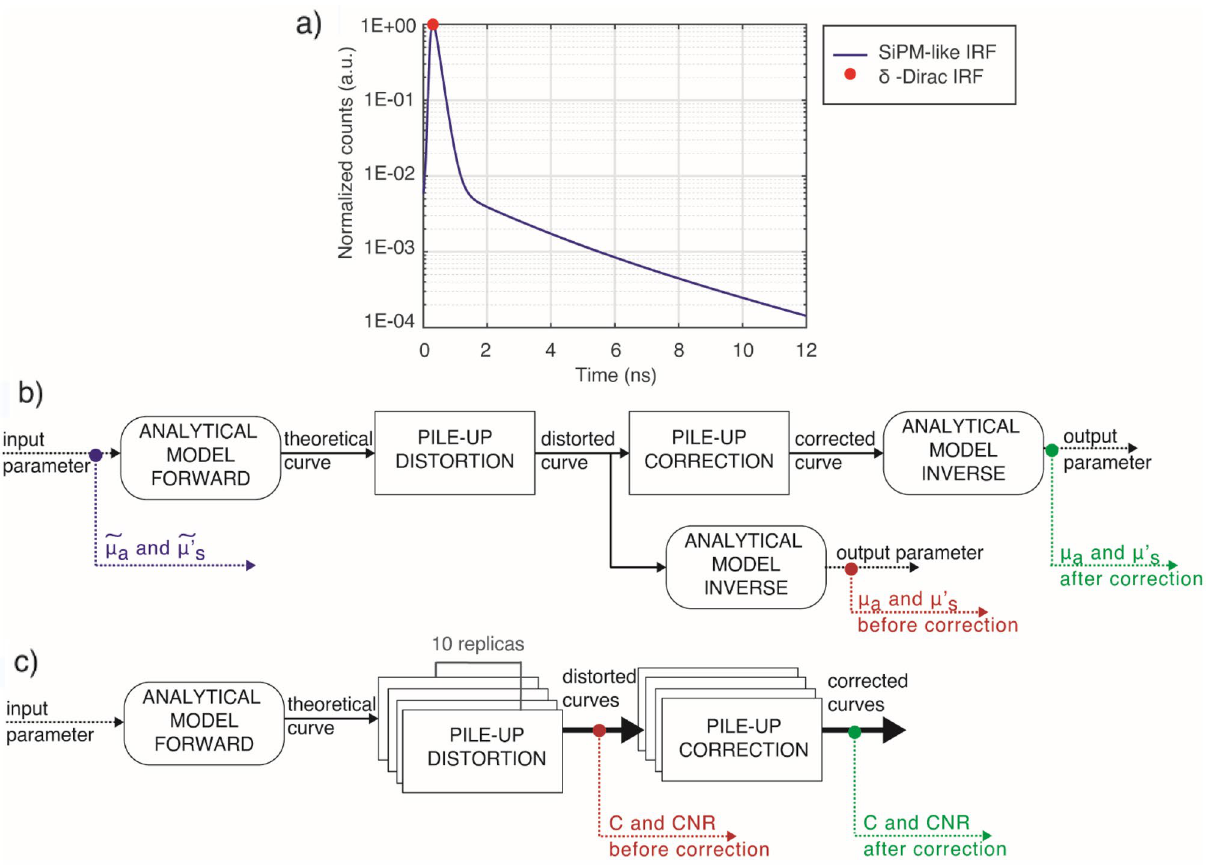
Figure 5. ( a ) Representation of IRFs used for simulations. Schematics of data generation and analysis for both MEDPHOT ( b ) and nEUROPt ( c )